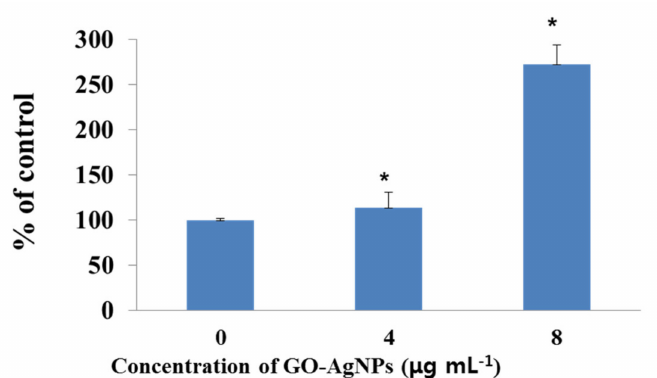
Figure 9. Measurement of caspase-3 activity in GO-AgNP-treated cells. Caprine fetal fibroblast cells (CFFCs) were treated with 0, 4, and 8 µ g/mL of GO-AgNPs for 24 h. The percentage of caspase- 3 activity relative to the control group (0 µ g/mL) was determined. Values are presented as the mean ± SD of four independent experiments (* p <